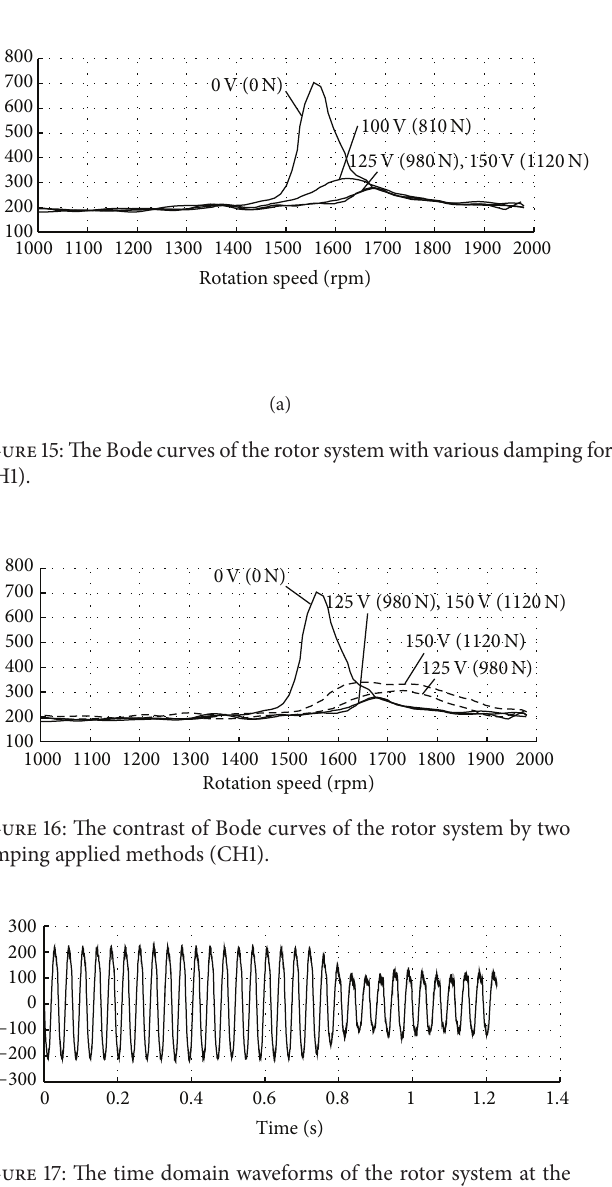
Figure 17: The time domain waveforms of the rotor system at the rotational speeds of 1524 rpm.